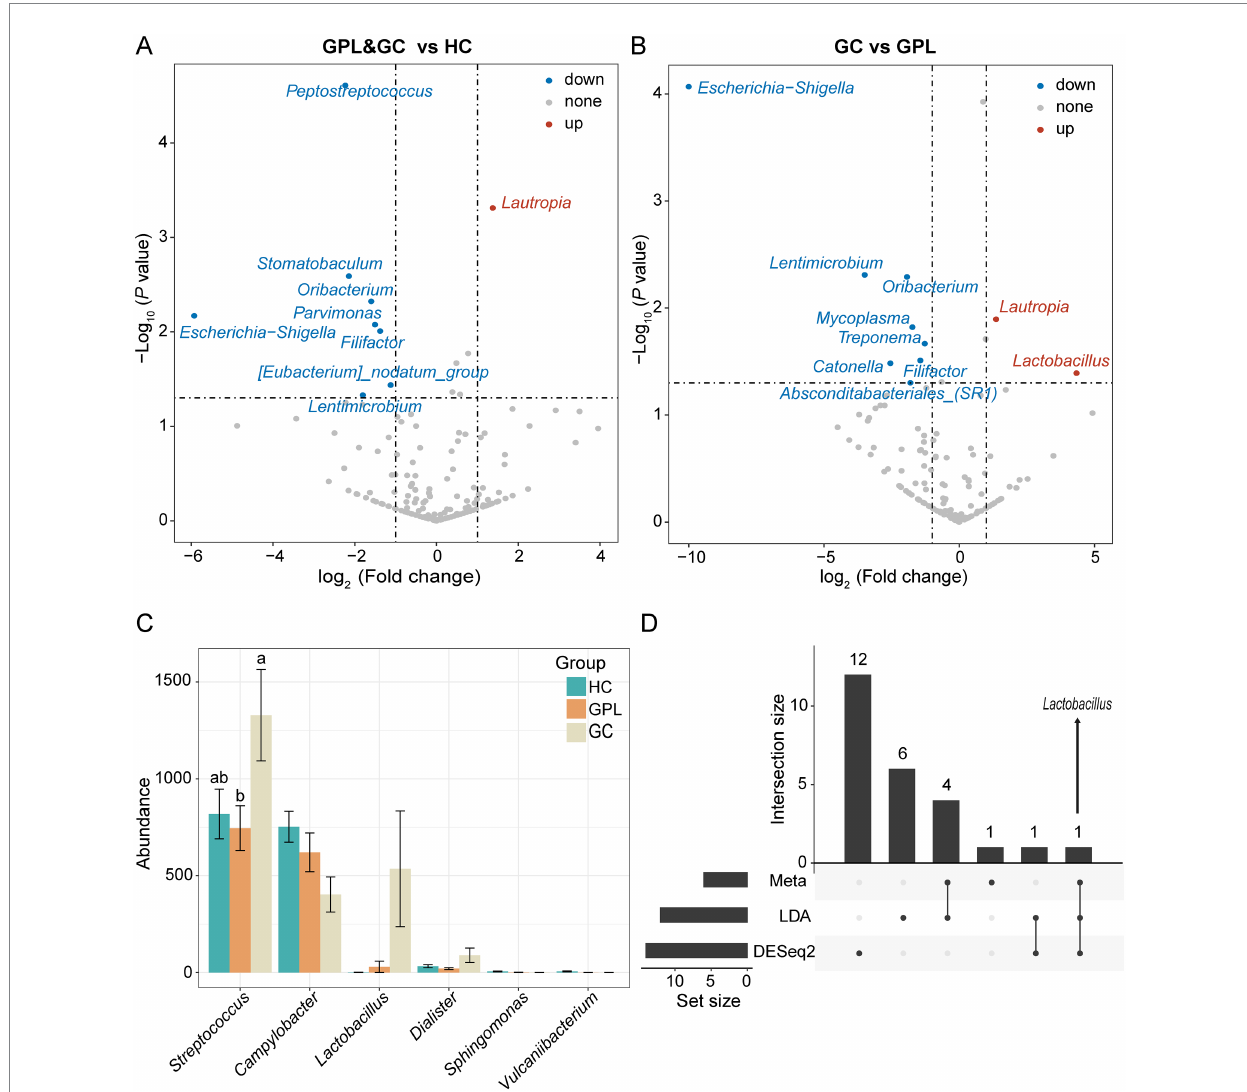
FIGURE 4 Differential abundance analysis at the species level. The volcano shows significantly up-regulated and down-regulated in the gastric precancerous lesions (GPL) and gastric cancer (GC) group compared with the healthy control (HC) group (A) ; GC compared with the GPL group (B) . The color of the nodes in the volcano marks the type of its change, blue indicates down-regulation, red indicates up-regulation, and gray indicates no significant difference between groups. (C) Differential abundance analysis at the genus level base on meta, LDA, DESeq2 and hub genus in co-occurrence network. The different relative abundance among three groups based on metastats. Significant differences among groups are indicated by alphabetic letters above the bars, determined by multiple comparison LSD-T test ( p < 0.05). (D) This upset diagram shows the biomarkers found based on Metastats, LDA and